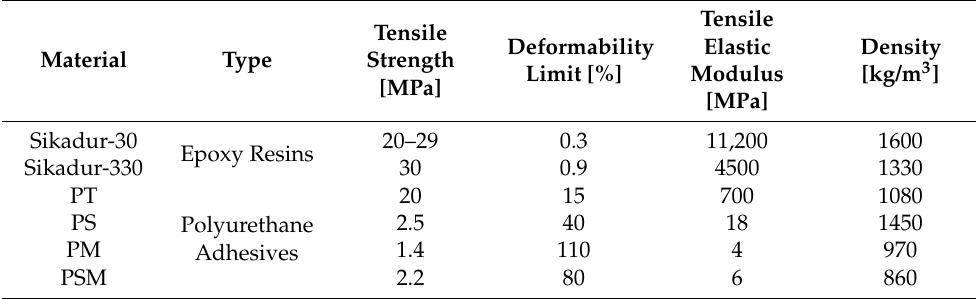
Table 3. The basic material properties of epoxy resins and polyurethane